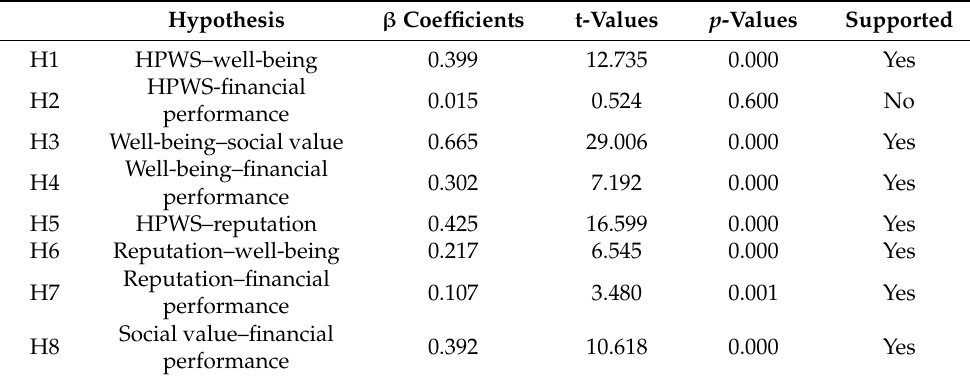
Table 5. Validation of the hypotheses. (Source: Own based on